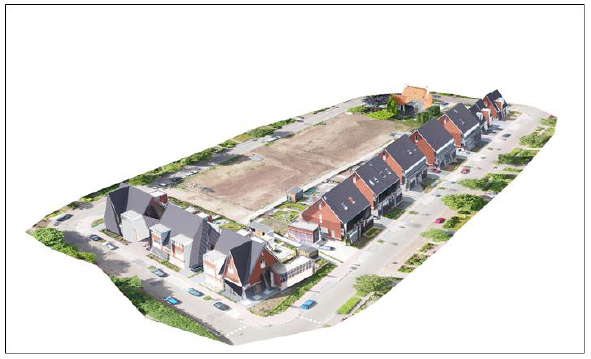
Figure 6: Textured 3D model created with elevation model and measured roof